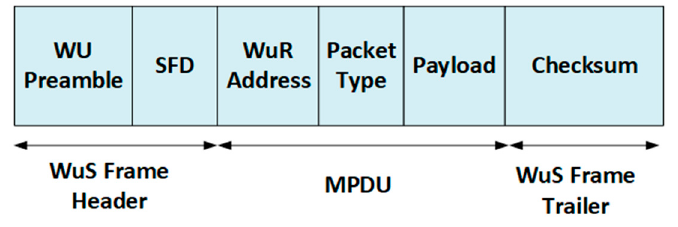
Figure 7. WuS frame structure.